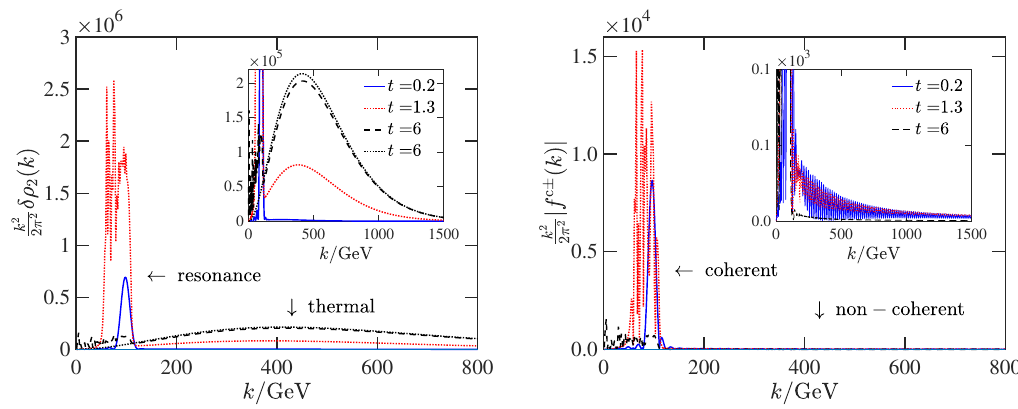
(cid:12) (cid:12) δρ 2 k (left) and k 2 (cid:12) f c ± k (cid:12) (right) for three 2 (cid:25) 2 2 (cid:25) 2 ω k n BE ( ω k ) for the equivalent 2 (cid:25) 2